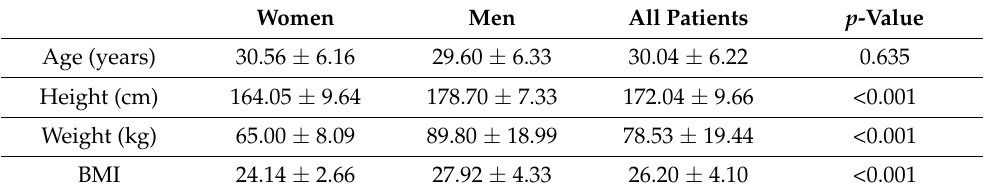
Table 1. Mean values and standard deviations of continuous variables for the study population (n = 55).